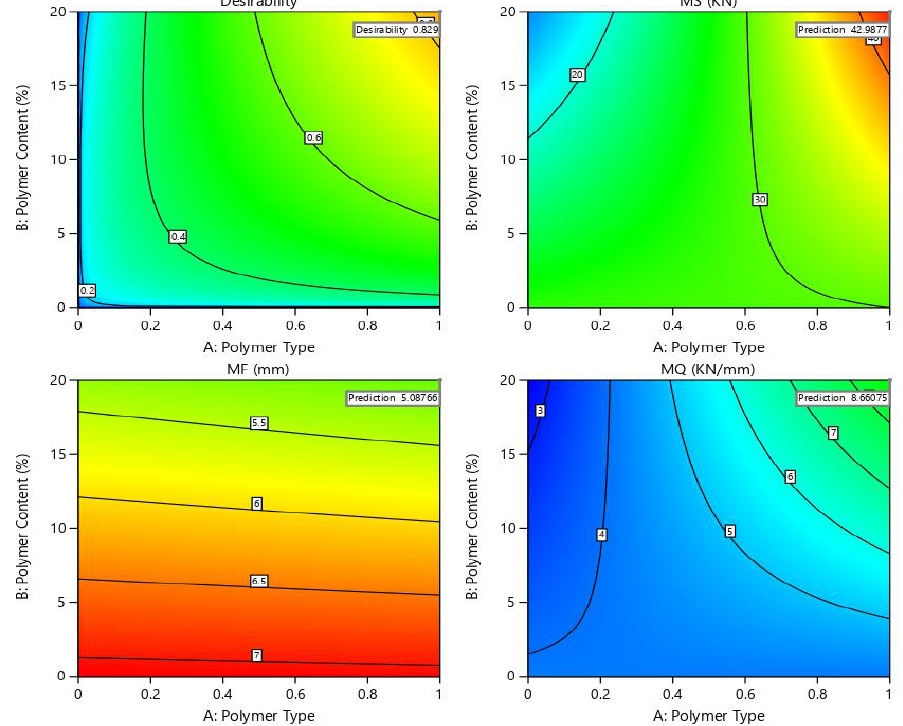
Table 5. Optimal prepared factors values in BBD-based RSM (predicted) and experimentally.